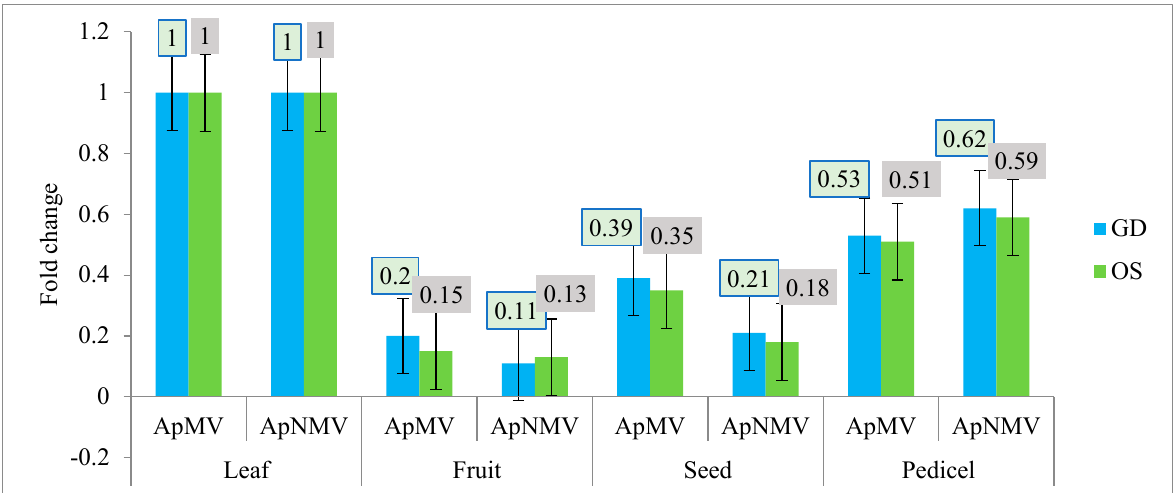
Figure 7. Comparative fold change of the CP gene of APMV and ApNMV in different tissues in cultivar Golden Delicious (GD) and Oregon spur (OS) during the autumn season. Y -axis represents the fold change in the virus infection, whereas X -axis represents different tissues tested for both viruses. Table 2. Relative quantification of ApMV and ApNMV in different tissues of two cultivars of Golden Delicious and Oregon Spur apple cultivars during the spring, summer and autumn sea- sons.